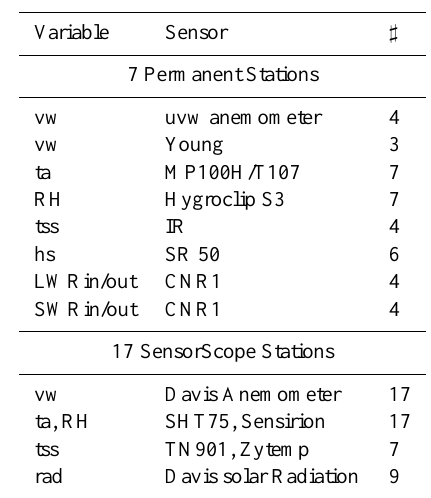
Table 1. Instrumentation: measured variables (Variable) (wind velocity (vw), air temperature (ta), relative humidity (RH), snow surface temperature (tss), snow depth (hs), incoming longwave ra- diation (LWRin), outgoing longwave radiation (LWRout), incom- ing shortwave radiation (SWRin), incoming shortwave radiation (SWRout), solar radiation (rad)); type of sensors (Sensors) and number of stations equipped with sensors ( ]